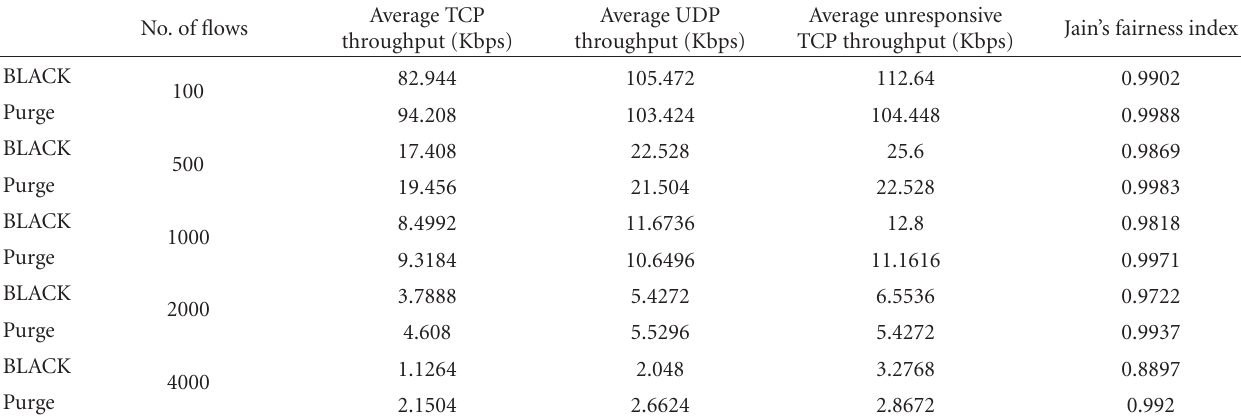
Table 2: Average throughput in multiple unresponsive flows scenario.